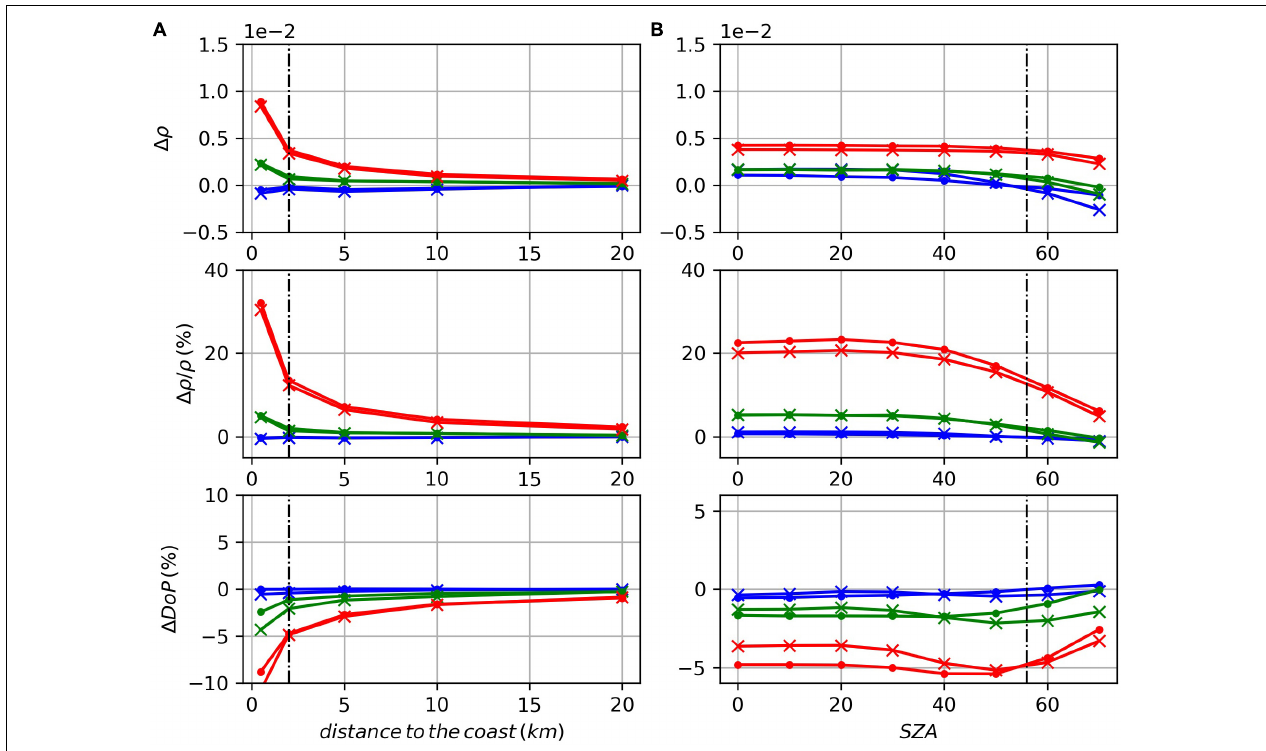
FIGURE 15 | Monte Carlo simulations of adjacency effects on the TOA reflectance of a water target next to a rectilinear coastline. Wavelengths are 412, 670, and 865 nm (blue, green, and red curves). (A) Absolute and relative TOA reflectance and degree of linear polarization differences between cases of heterogeneous and homogenous surface as a function of distance to the coast. Solar and view angle are 56 ◦ and 45 ◦ , and relative azimuth angle is 90 ◦ . (B) Same as panel (A) , but as a function of the Sun zenith angle (SZA, in degrees) for a distance to the coast of 2 km. Curves with solid circles correspond to the sensor located over ocean and curves with crosses to the sensor located over